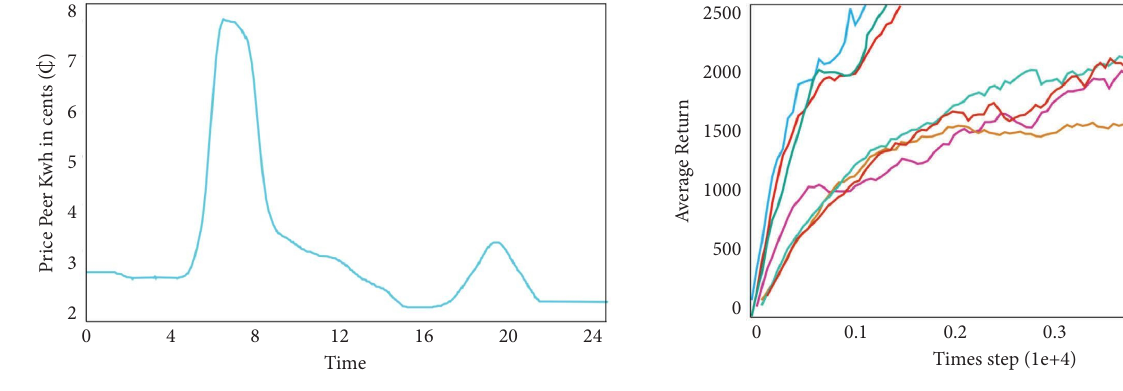
Figure 4: Hourly electricity prices of San ComEd.